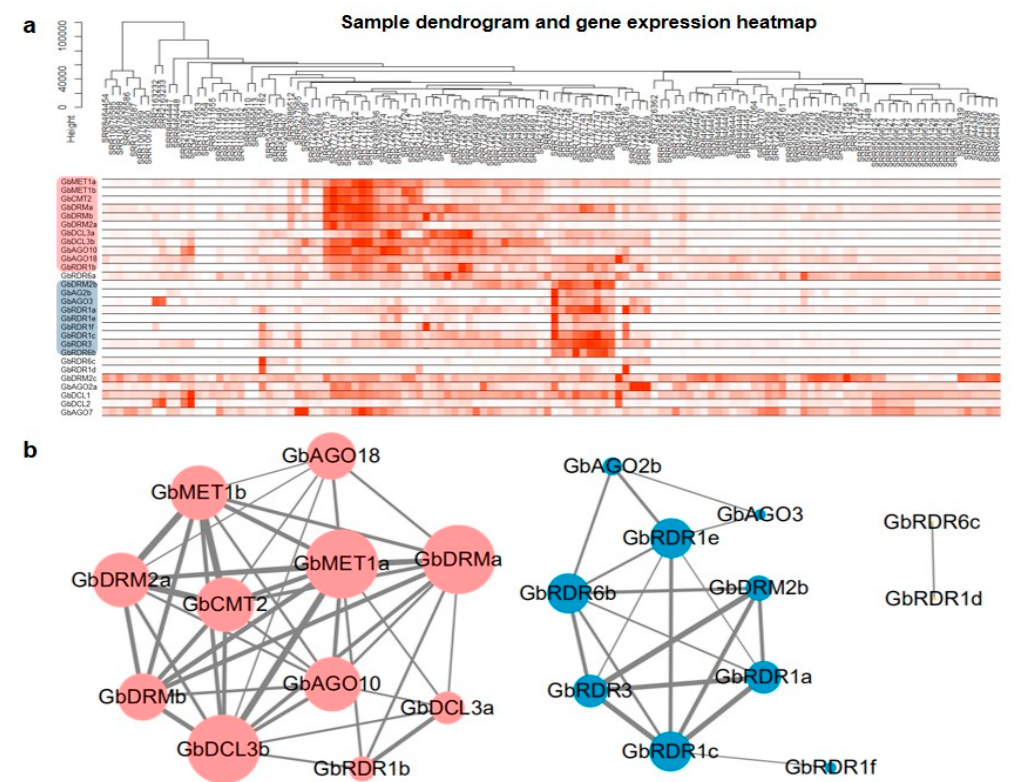
Figure 5. Coexpression analysis of DNA methylation pathway genes. ( a ) Expression profile of all genes in the 126 transcriptomic datasets download from NCBI, and ( b ) coexpression network of DNA methylation pathway genes with a Pearson correlation coefficient (PCC) higher than 0.65. Genes are clustered into two groups (pink and blue).